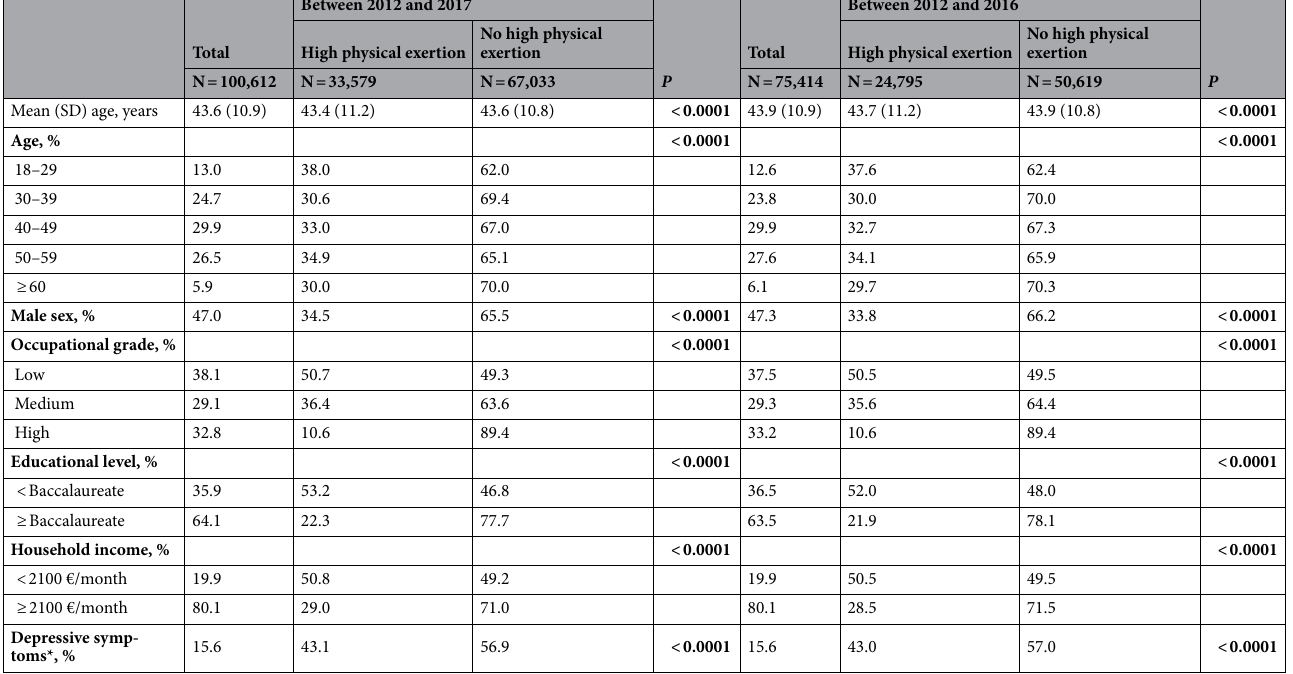
Table 1. Baseline characteristics of 100,612 and 75,414 employees included between 2012 and 2017 (to study tobacco and cannabis use) and 2012–2016 (to study alcohol use and diet rich in sugar and fat), respectively by exposure to physical exertion in the CONSTANCES cohort study. Independent t-tests and Chi-square tests were computed for continuous and categorical variables, respectively. Significance values are given in bold. *Depressive symptoms were defined as having a CES-D score ≥